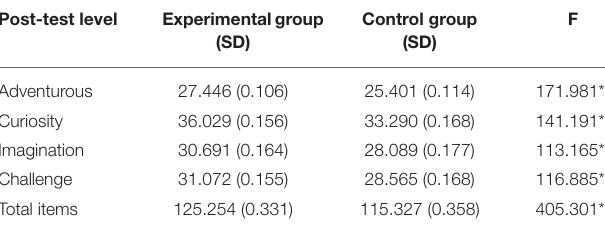
TABLE 2 | Summary of ANCOVA on students’ creativity. TABLE 3 | Paired sample T -test for each dimension before and after the